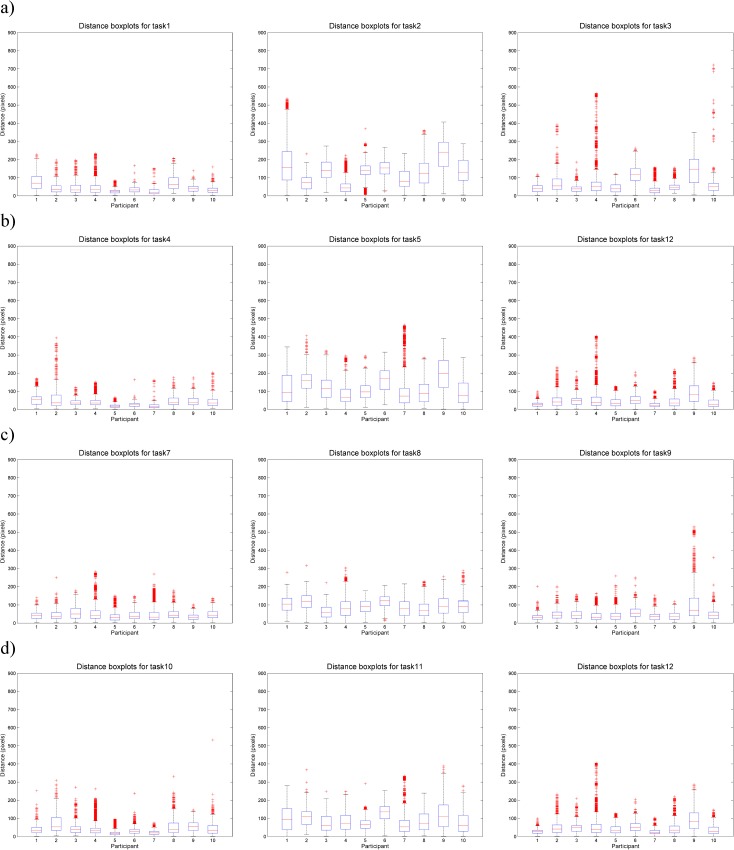
Box-and-whiskers plots of gaze-mouse distance per participant.Plots are shown for tracing a) the circle, b) the rectangle, c) the curve and d) the star. Each row shows three charts: for natural tracing, for eye-first and for mouse-first. Each boxplot in each chart is the distribution of eye-mouse distance for one participant, where participants are ordered in the same way across all charts and all charts are shown at the same scale, to allow for visual comparison across each geometric form (per row) and across all forms (per column).